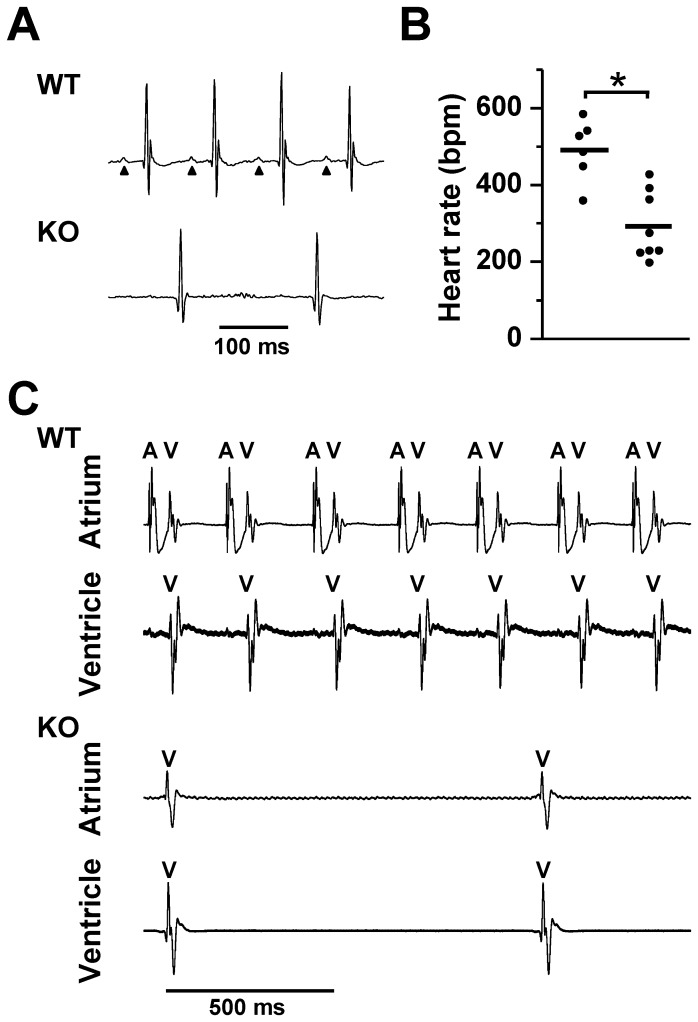
Sinus arrest and junctional rhythm in NCX1 KO mice.
A. Representative telemetry ECGs from WT and atrial-specific NCX1 KO mice. WT mice were in normal sinus rhythm, with each P wave (arrows) followed by a typical murine QRS complex. In KO mice, P waves were conspicuously absent and a slow junctional escape rhythm (narrow QRS) was present. B. Mean ventricular (heart) rate in KO mice was lower than in WT mice (thick line, *P<0.001). C. Upper panels show simultaneous bipolar atrial and ventricular electrograms recorded from a representative WT heart. In the atrial lead, atrial (A) spikes are always followed closely (after physiologic delay) by a far-field ventricular (V) spike. The V spike is clearly shown in the ventricular lead below. The electrograms from a KO heart shown in the bottom panels exhibit only a V spike in both the atrial and ventricular leads indicating electrical silence of the atrium, consistent with the lack of P waves shown in A. There is no evidence of atrial fibrillation in the A lead of the KO heart.